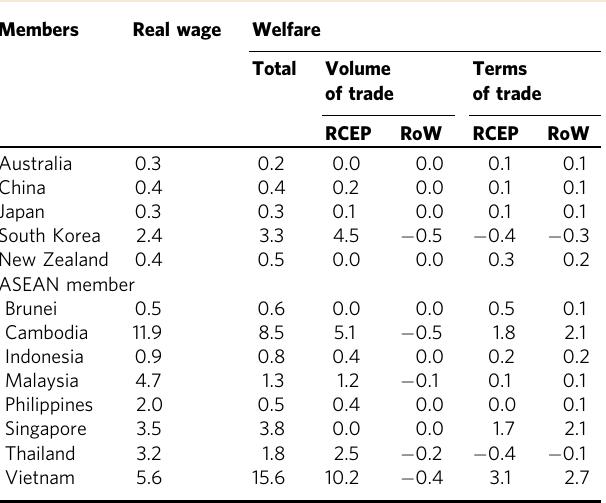
Table 1 Welfare effects of the RCEP tariff elimination on member countries